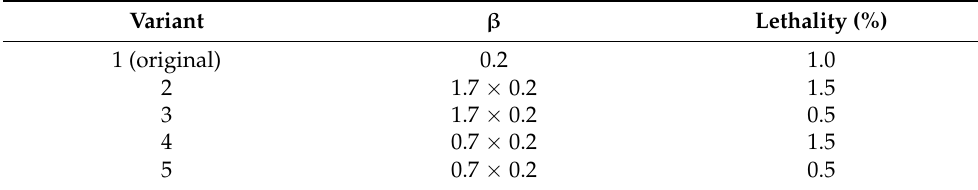
Table 1. Contagion ( β ) and lethality of the original and variant strains used in the second model. Variant